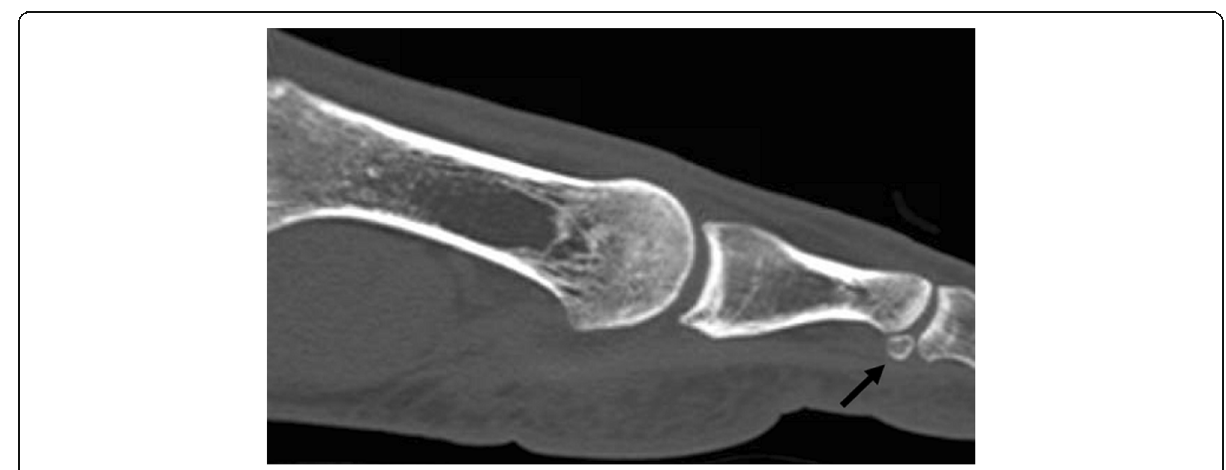
Fig. 15 Interphalangeal joint sesamoid. A 33-year-old man referred for flat foot. Incidental finding of an interphalangeal joint sesamoid. Sagittal CT reconstruction better demonstrates its position with respect to the interphalangeal joint (black arrow). A potential complication arises if there is a phalangeal dislocation and the ossicle displaces into the joint space, blocking